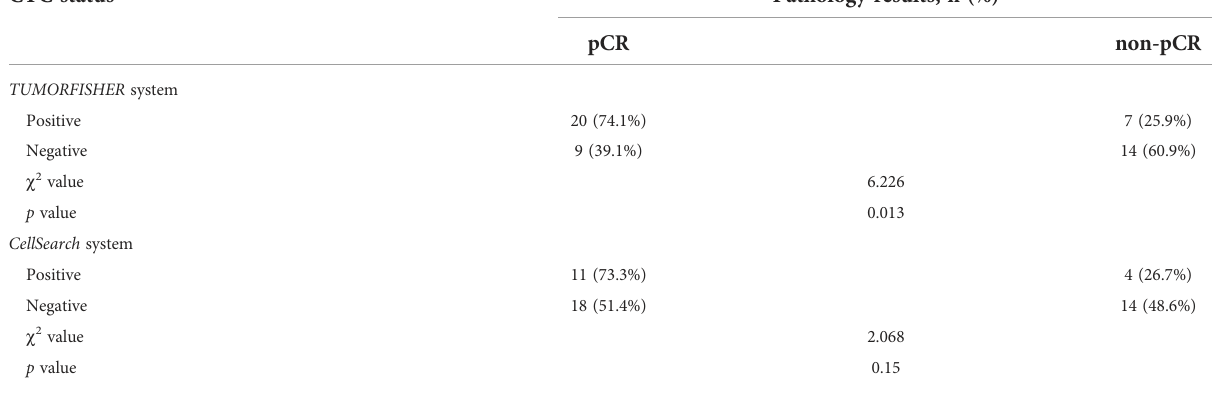
TABLE 4 Relationship between CTC levels before neoadjuvant therapy and pCR in 50 patients.